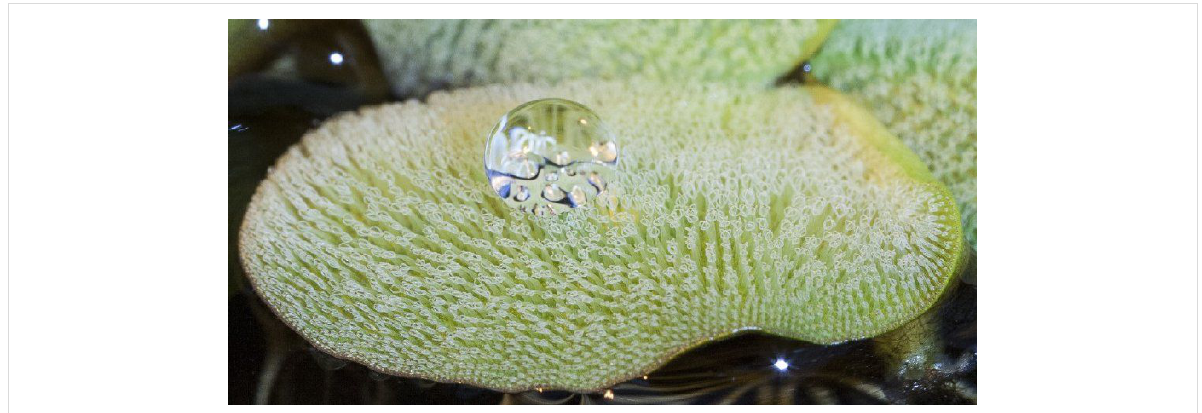
Figure 1: Leaf of Salvinia molesta floating on water. The leaf surface is densely covered with complex superhydrophobic “egg-beater” hairs. The height of the hairs decreases towards the margin of the leaf. An applied water droplet resides on the tips of the hairs without sinking between the